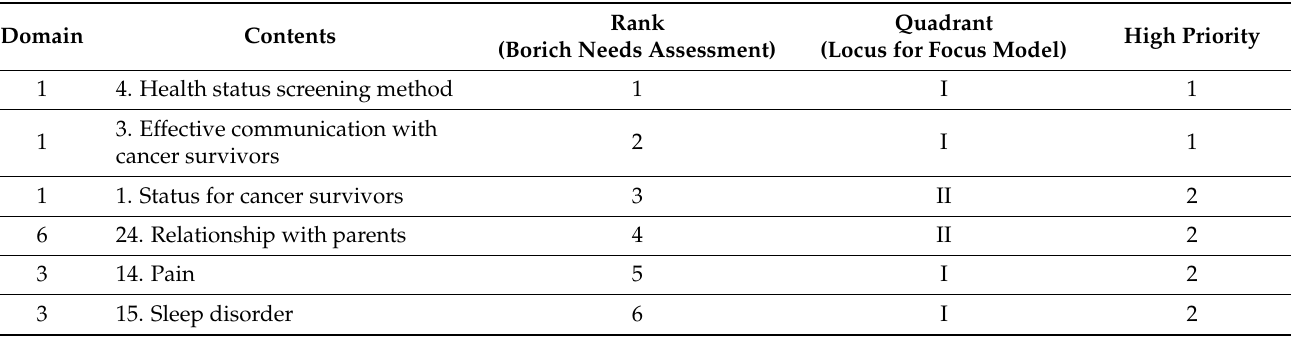
Table 4. Needs of forest healing instructors according to Borich needs assessment model and the Locus for Focus